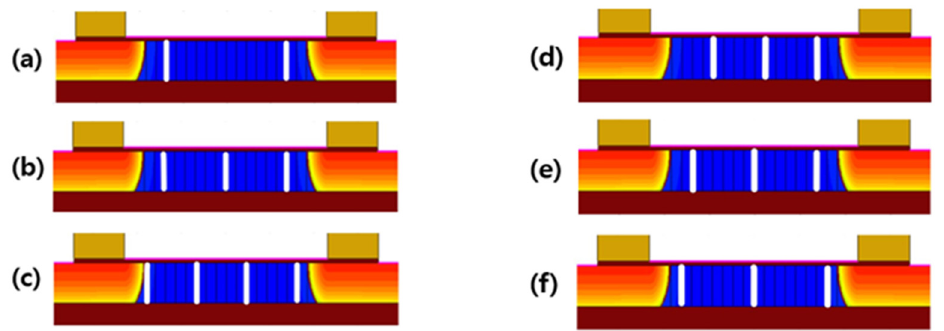
Figure 5. The simulated structure of poly-Si body 1T-DRAM with ( a ) 2 GBs; ( b ) 3 GBs; and ( c ) 4 GBs in a channel; ( d–f ) the simulated structure of 3 GBs poly-Si body 1T-DRAM with di ff erent GBs location /@T = 300 K.